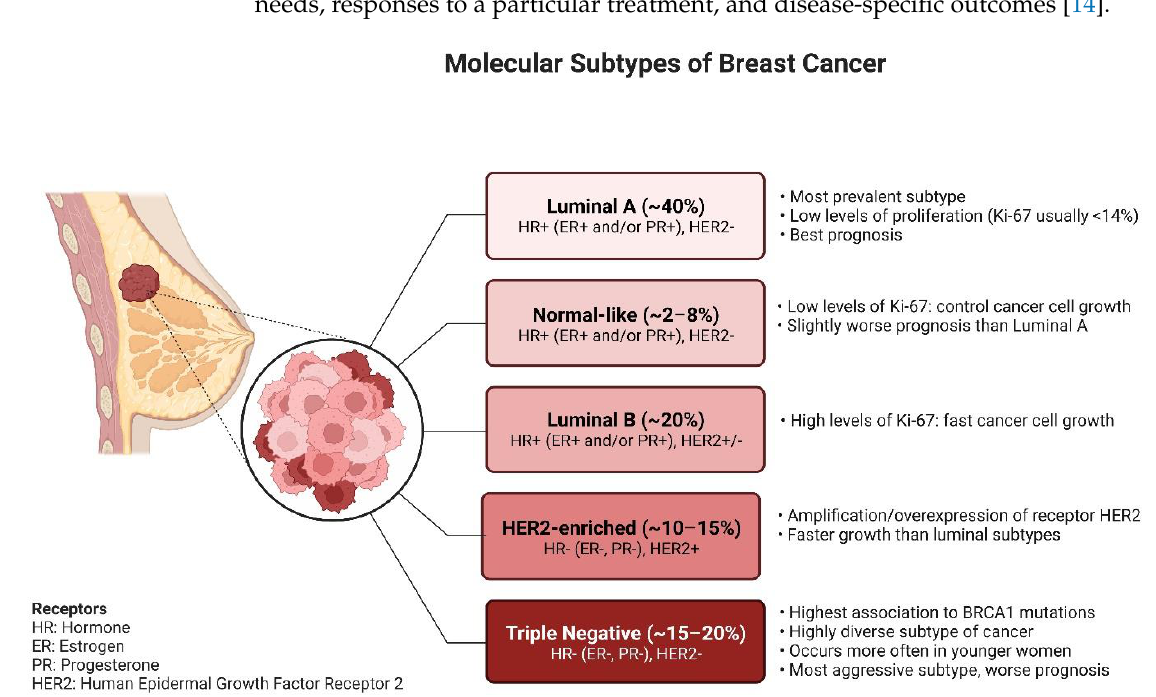
Figure 1. Classification of breast cancer. The above figure was created with BioRender.com. Agree- ment number: MV24QP1OWO .